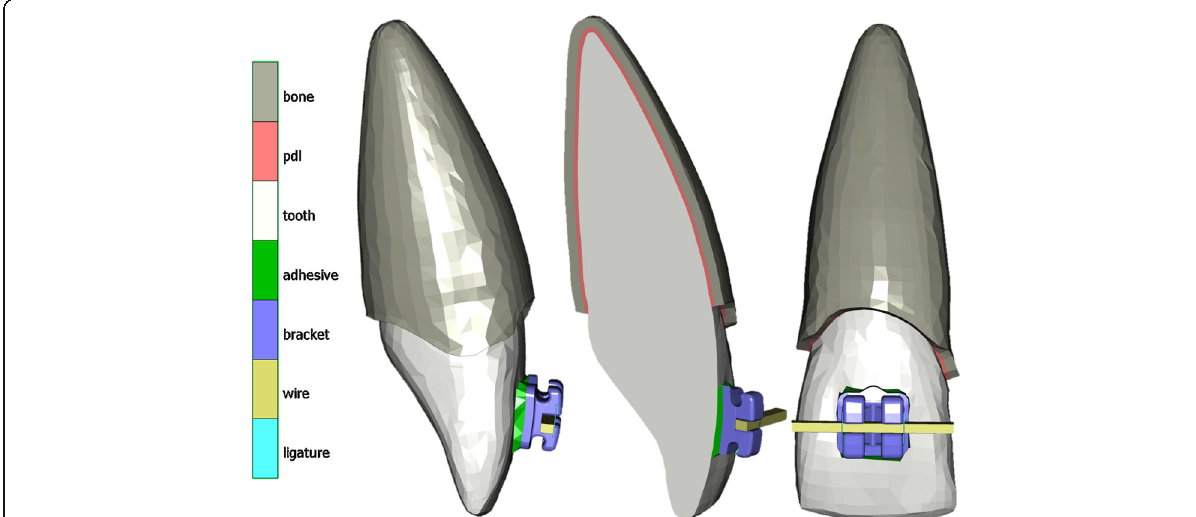
Fig. 1 Details of the constructed model with cortical bone layer, periodontal ligament, tooth, adhesive layer, bracket, wire, and ligatures. The outer bone surface was held (boundary condition: fixed nodes in all three